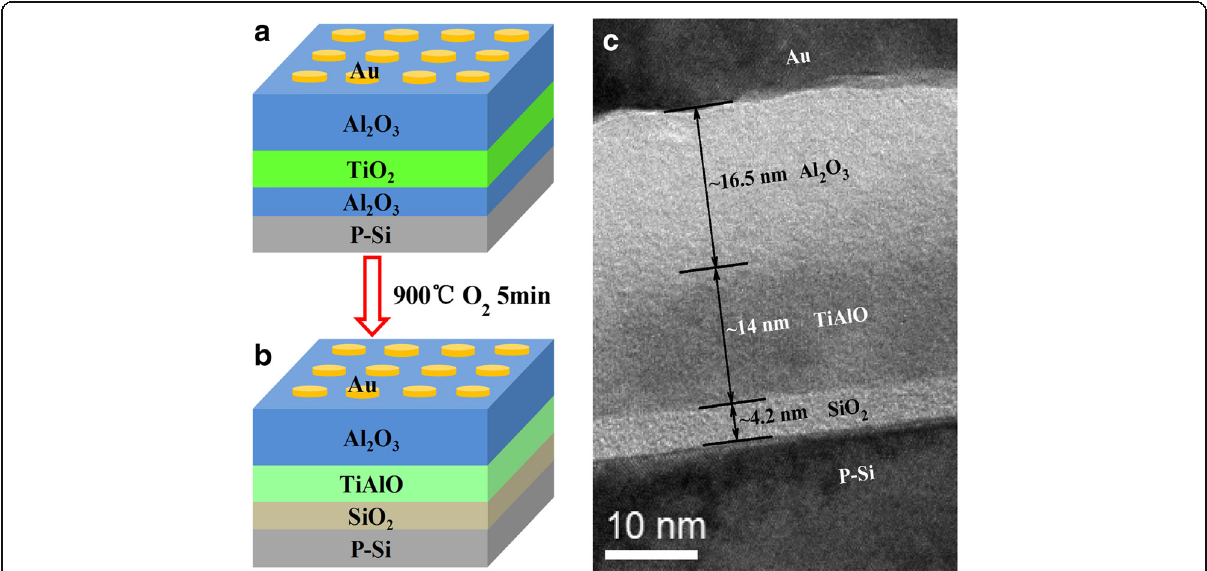
Fig. 1 ( Color online ) a The schematic diagram of the nominated Al 2 O 3 /TiO 2 /Al 2 O 3 charge-trapping memory device structure. b The schematic diagram of the charge-trapping memory device structure after 900 °C annealing. c The HRTEM cross-sectional image of the actual charge-trapping memory device used in our